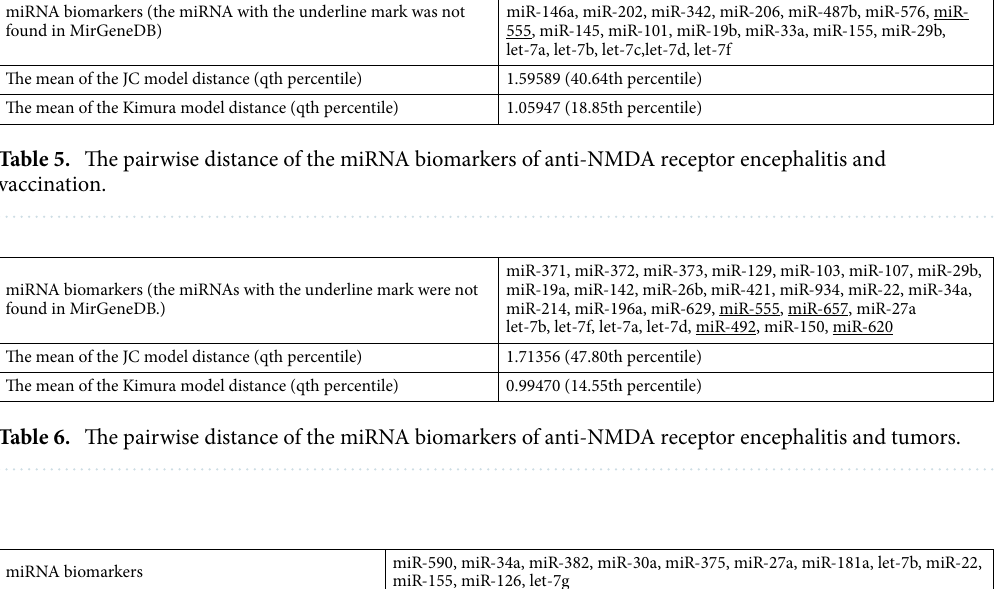
miRNA biomarkers (the miRNA with the underline mark was not found in MirGeneDB)